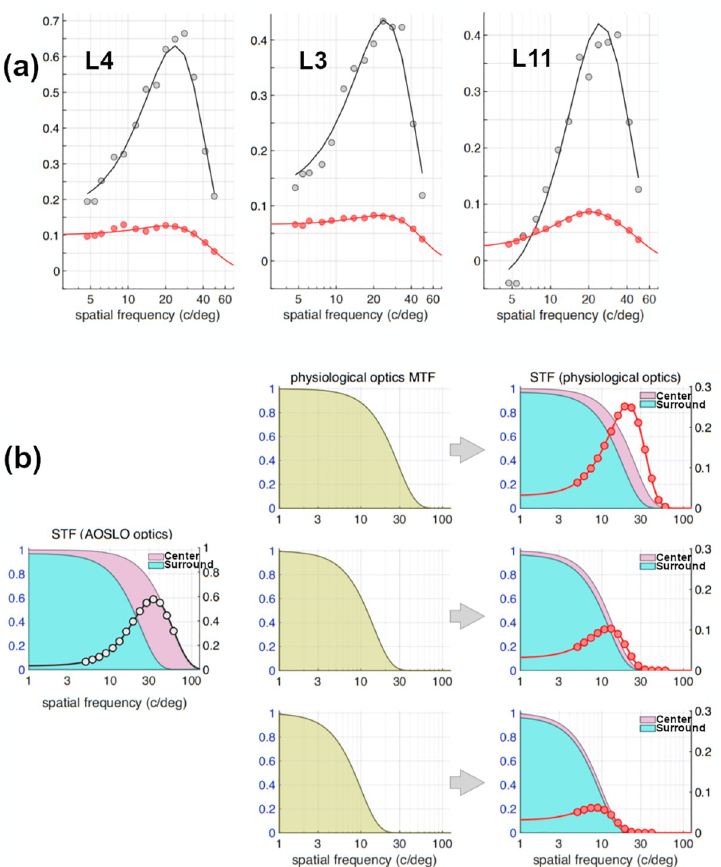
Fig 9. Effect of physiological optics on RGC STFs. a. Gray disks depict STF data measured using the AOSLO for three RGCs, and the black lines show the STFs from the ISETBio model fit to these cells. The cone weights from the model fits are used to predict the STF that would be measured under the animal’s own physiological optics (as characterized by wavefront-aberration measurements taken during the experiment) with a 2.5 mm pupil. These model-predicted STFs are depicted by the red disks. A simple DoG model is then fitted to the predicted STF data (red line) for comparison to measurements obtained in traditional in vivo neurophysiological experiments (e.g. Croner & Kaplan [9]). b. Demonstration of the effect of physiological optics on the STF. The left panel depicts the STFs of the RF center and the RF surround of a model RGC as they would be measured using diffraction-limited optics (pink and blue, respectively), whereas the composite STF is depicted by the gray disks. The middle panels depict the MTFs of three hypothetical physiological optical systems with progressively larger Gaussian point spread functions. The corresponding STFs that would be measured under these physiological optical systems are depicted in the right panels. Note the difference in scale between left y-axis (for the center and surround STFs) and right y-axis (for composite